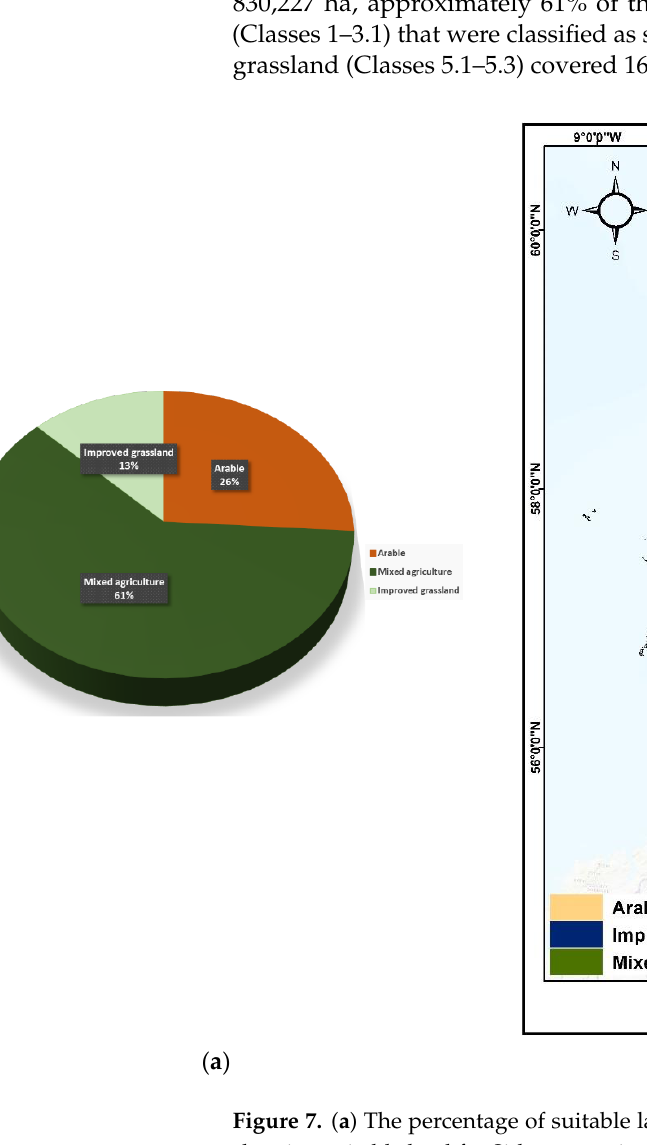
Table 10. Area and percentage of suitable for afforestation with Sitka spruce in each LCA class.